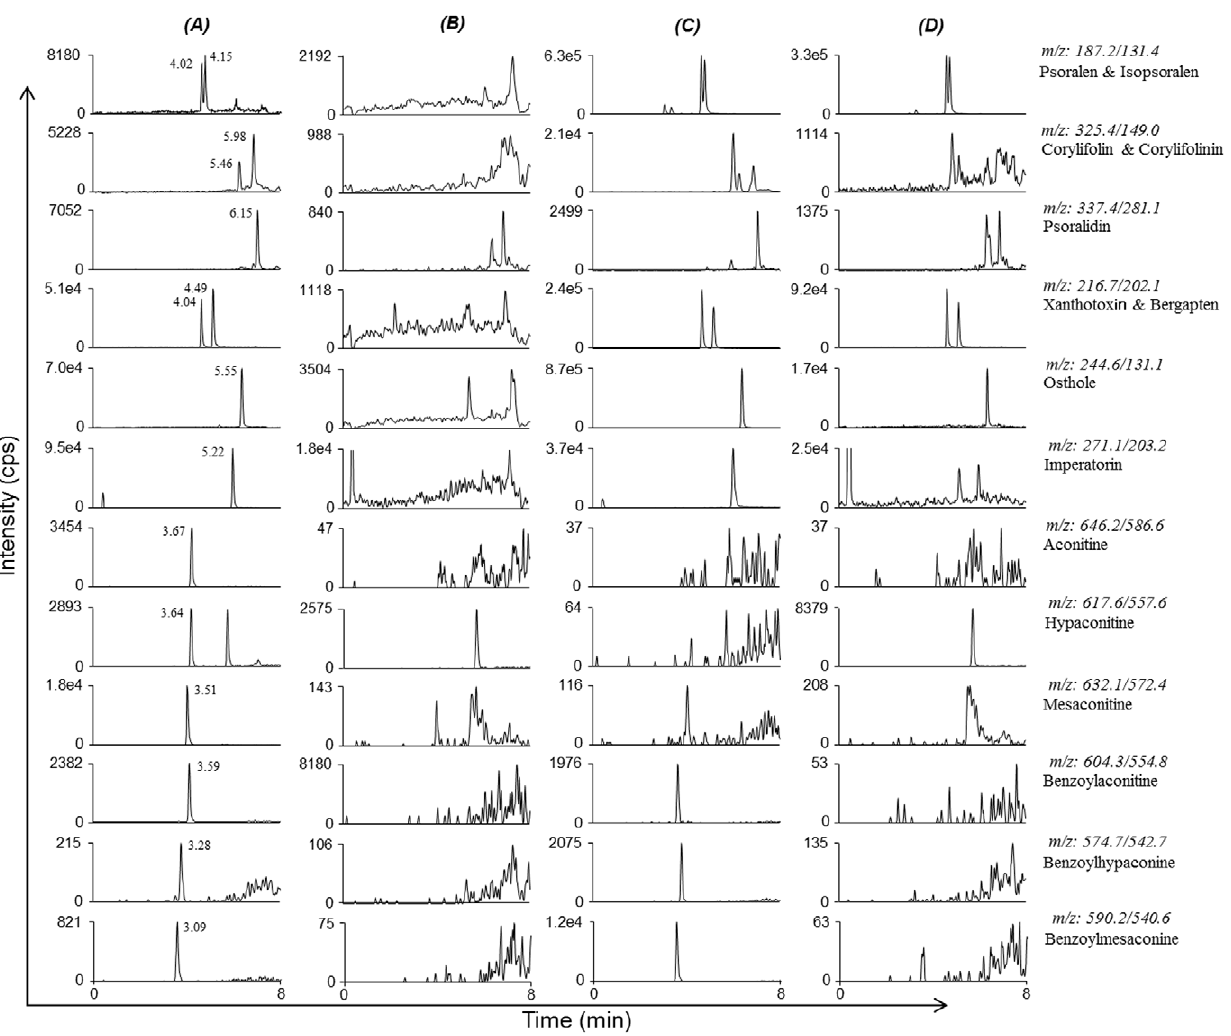
Figure 2. LC-MS/MS chromatograms of 15 constituents (A) blank rat plasma sample spiked with 15 standards; (B) blank rat plasma sample; (C) decoction of BZ; (D) rat plasma sample collected after single oral dose of BZ.